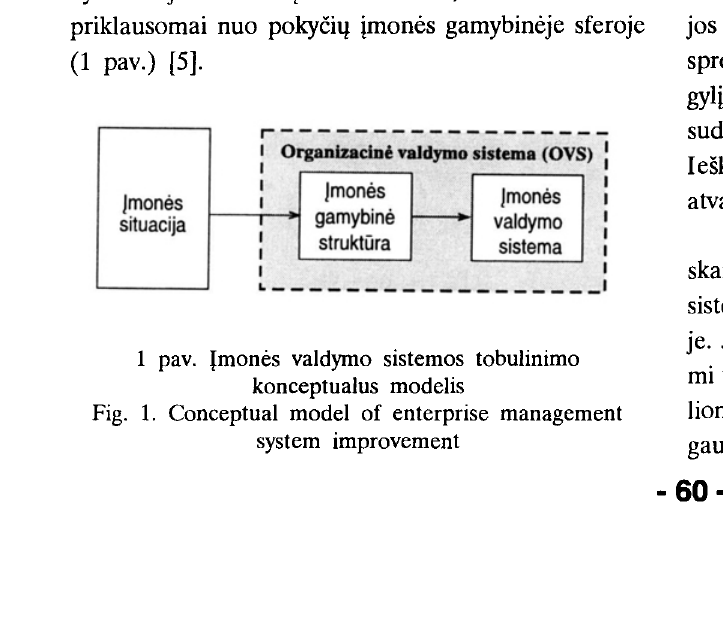
Fig. 1. Conceptual model of enterprise management system